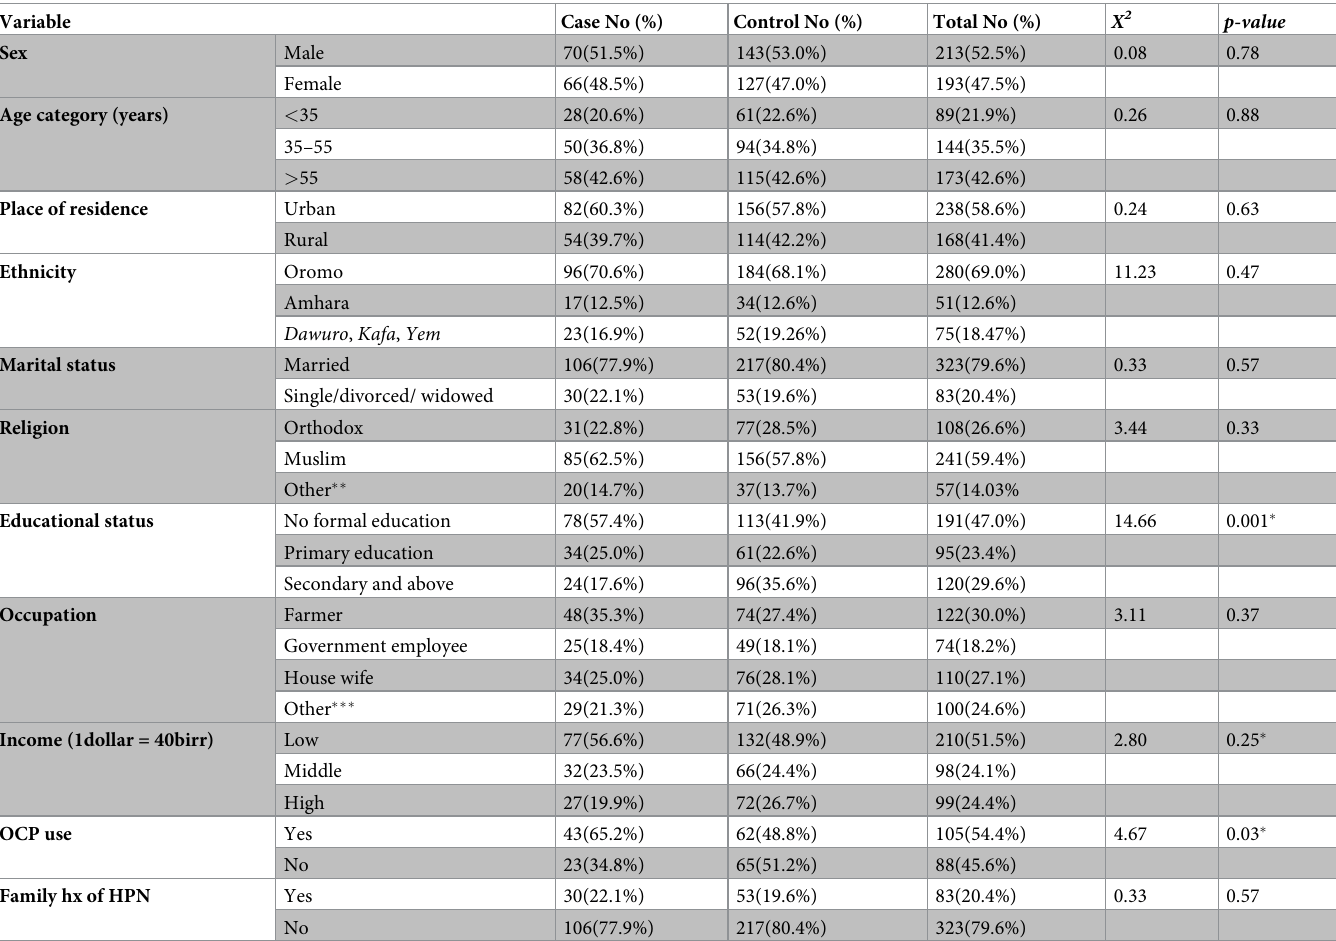
Table 1. Socio-demographic characteristics of study participants, Southwest Ethiopia,